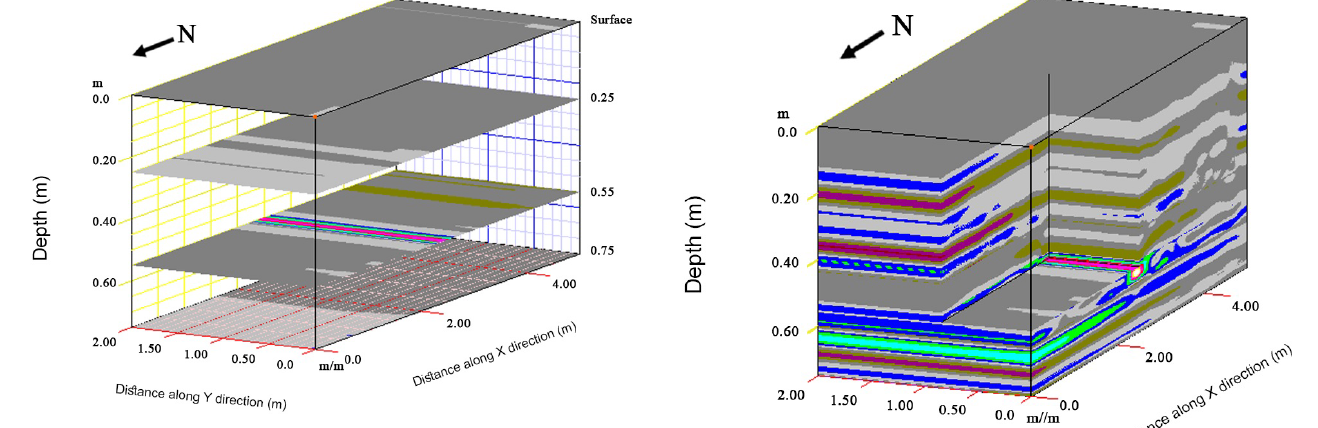
Figure 10. Depth slices with different depths (0, 025, 0,55, 0.75m) generated from 3D plot . The main anomaly observed with W-E direction at depth slice 0.55mb.s. (meter below surface).